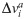
Mechanisms for SNP influence sign alterations.(A) Examples of local interactions of a polymorphic TFBS (red box) with other TFBSs (blue boxes) leading to alternating sign of SNP influence on expression. The horizontal lines represent segments of the regulatory region. Activating (repressing) TFBSs are shown above (below) these lines and labeled with ‘A’ (‘R’). The SNP position is marked via a short vertical line. In 3), the SNP appears in the overlap region of two TFBSs, so both sites are polymorphic in this picture. They are shown at the center of the DNA line to express that both sites can be either activating or repressing (in any combination) in this situation. In 4) and 5), d1 and d2 indicate the range of repression from sites R1 and R2, respectively. The activating site is repressed by both repressors in 4) and only by R2 in 5). (B) Graphs of the difference Δvia as a function of the spatial position i on the A–P axis of the embryo in the mid-cleavage cycle 14A (time class T4) and for the gene Kr. The graphs are shown for one genotype from the study population and its three SNPs from the regulatory region of Kr. The indices of these SNPs (#73, 81, and 88) are according to S2 Table. SNP #73 has the genomic position 21106823 and corresponds to the change of nucleotide G to A; SNP #81, 21113108, T/G; SNP #88, 21113686, C/T. Each SNP appears in multiple overlapping TFBSs of multiple TFs (S2 Table). (C) Dynamics of Δvia for the same genotype, gene, and SNPs as in (B), shown for time classes T1–T8 in the cleavage cycle 14A and for nucleus i = 54. The blue curve in (B) and (C) demonstrates the alternating sign of SNP influence.